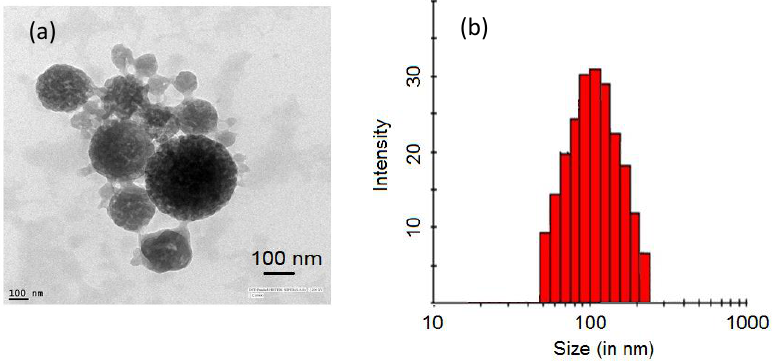
Figure 4. ( a ) TEM analysis and ( b ) Particle size distribution (DLS) of the synthesized In 2 O 3 nanoparticles.